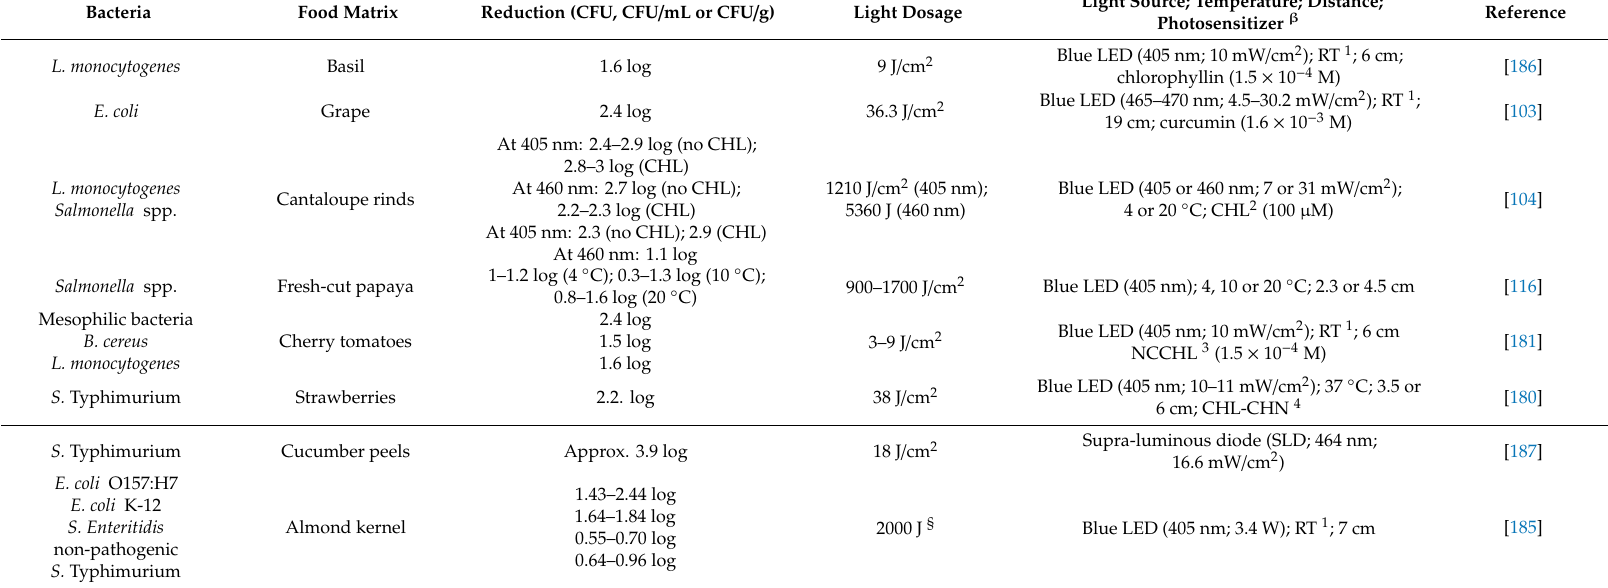
Table 3. Blue light inactivation of pathogenic bacteria in horticultural